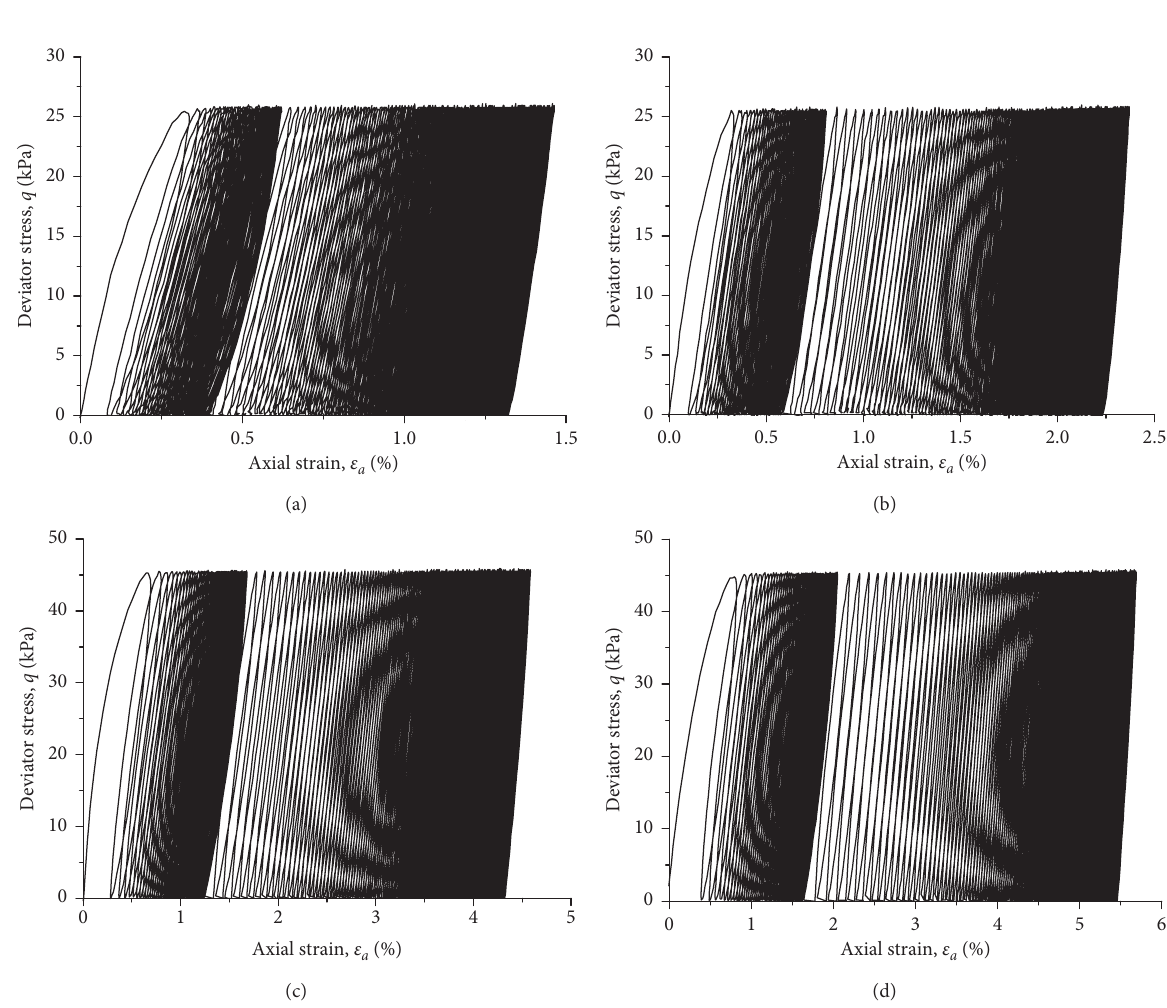
Figure 4: Typical stress–strain hysteretic loops: (a) CSR � 0.347, η ampl � 3; (b) CSR � 0.347, η ampl � 0.5; (c) CSR � 0.625, η ampl � 1; (d) CSR � 0.625, η ampl �